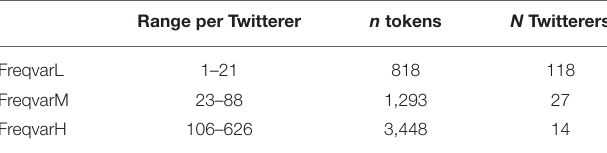
TABLE 6 | Distribution of number of Twitterers ( N = 159) and tokens ( n = 5,559), split up in three frequency groups. Range per Twitterer n tokens N Twitterers FreqvarL